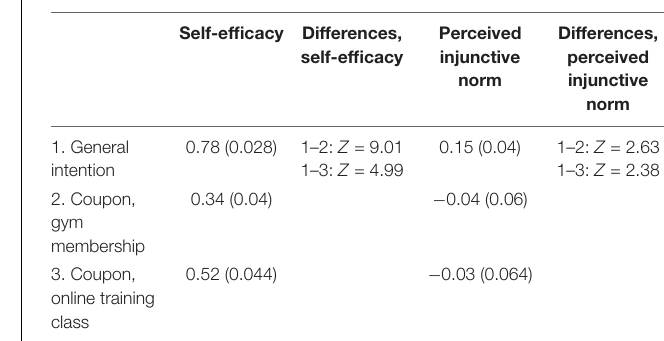
TABLE 5 | Comparisons of the effect of self-efficacy and perceived injunctive norm on general versus specific workout intentions; standardized coefficients presented with SEs in the